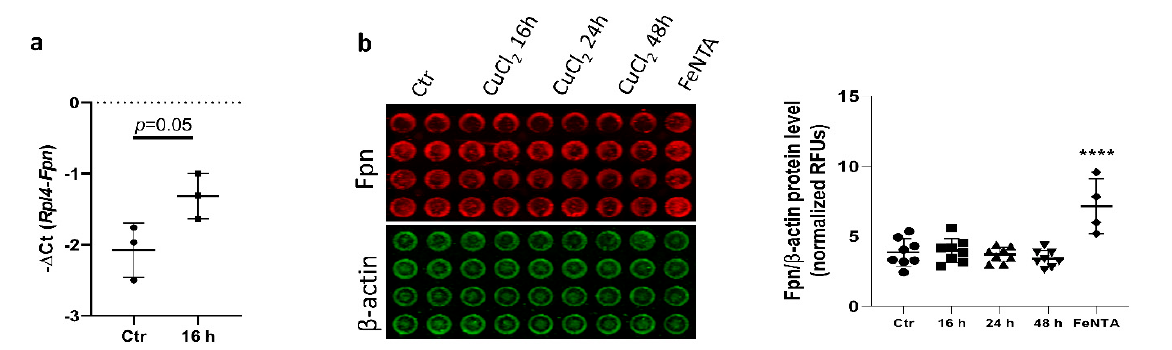
Figure 6. CuCl 2 treatment does not affect Fpn mRNA and protein levels in primary peritoneal macrophages. ( a ) qPCR analysis of Fpn mRNA expression in primary peritoneal macrophages incubated with 150 µ M CuCl 2 for 16 h. Data represent mean ± SD. ( b ) In-Cell Western blot detection (left panel) and quantification (histogram) of Fpn expression in peritoneal macrophages treated with 150 µ M CuCl 2 for 16, 24, and 48 h. Cells treated with Fe-NTA (200 µ M) were used as positive control. Fpn intensity signal was normalized to β -actin level. Data on histogram represent mean ± SD, **** p < 0.0001.